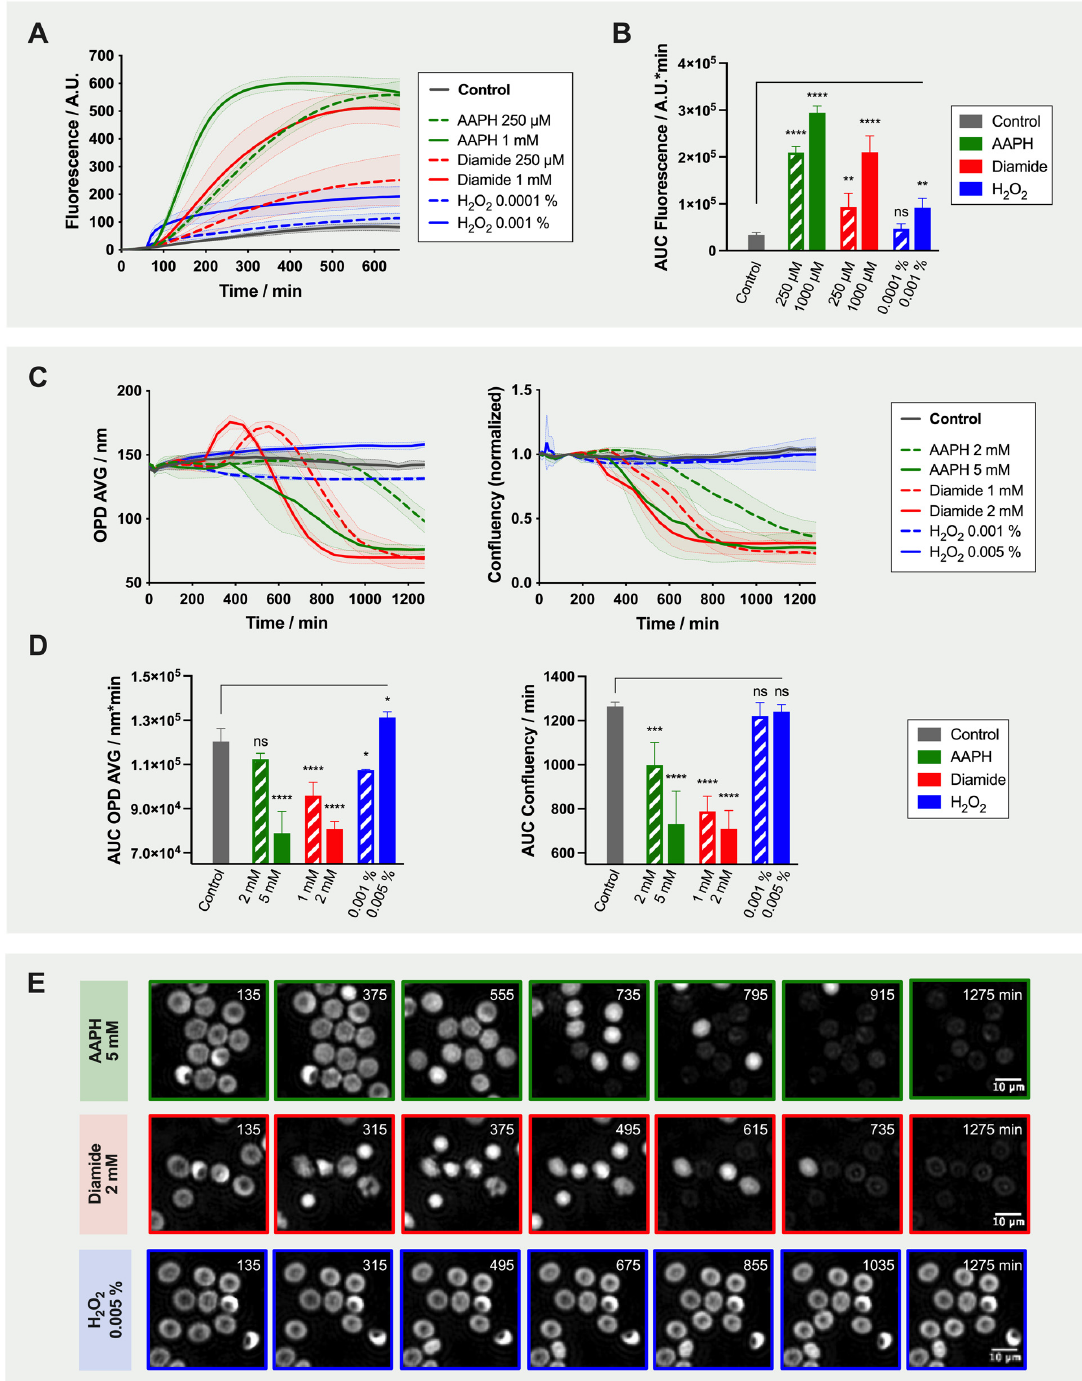
Figure 2. Time-Lapse Analysis of the Effects of Different Oxidants (i.e., AAPH, Diamide and H 2 O 2 ) on the Oxidative Stress and Morphology of Red Blood Cells (RBCs). ( A ) Fluorescence emission induced by AAPH, diamide, H 2 O 2 or no-oxidant treatments. ( B ) Area under the curve (AUC) calculated from fluorescence curves. ( C ) Morphological changes induced by AAPH, diamide, H 2 O 2 or no-oxidant treatments. Left: average of the optical path difference distribution (OPD AVG) parameter; right: normalized confluency. ( D ) AUC calculated from OPD AVG and confluency curves. For the AUC, two-way ANOVA was performed to compare the effect of the three oxidants at different concentrations with a “no-oxidant” control; * p -value < 0.05, ** p -value < 0.01, *** p -value < 0.001, **** p -value < 0.0001, and “ns” non-significant. ( E ) Evolution of the morphology of RBCs treated with oxidants. Illustrative phase images acquired by digital holographic microscopy (DHM) at seven time